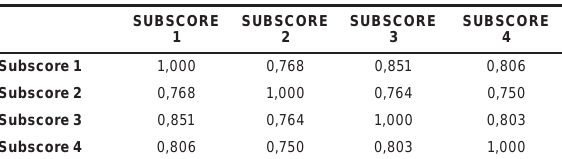
TAbLE 3 Matrix of intercorrelations of subscores